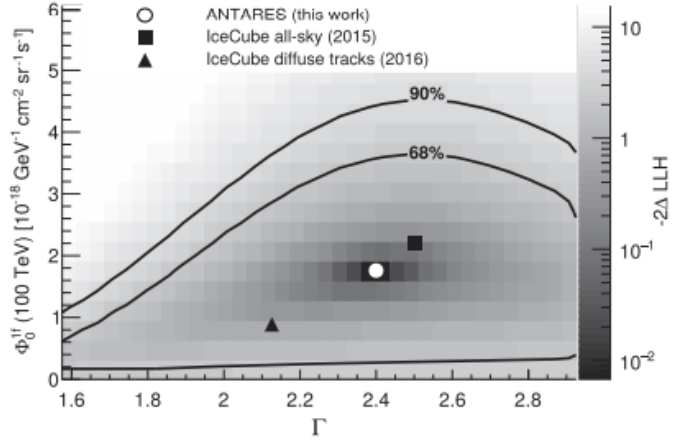
Figure 2 . 2D log-likelihood scan of the diffuse cosmic fl ux normalization and spectral index. Black lines indicate 90% and 68% confidence